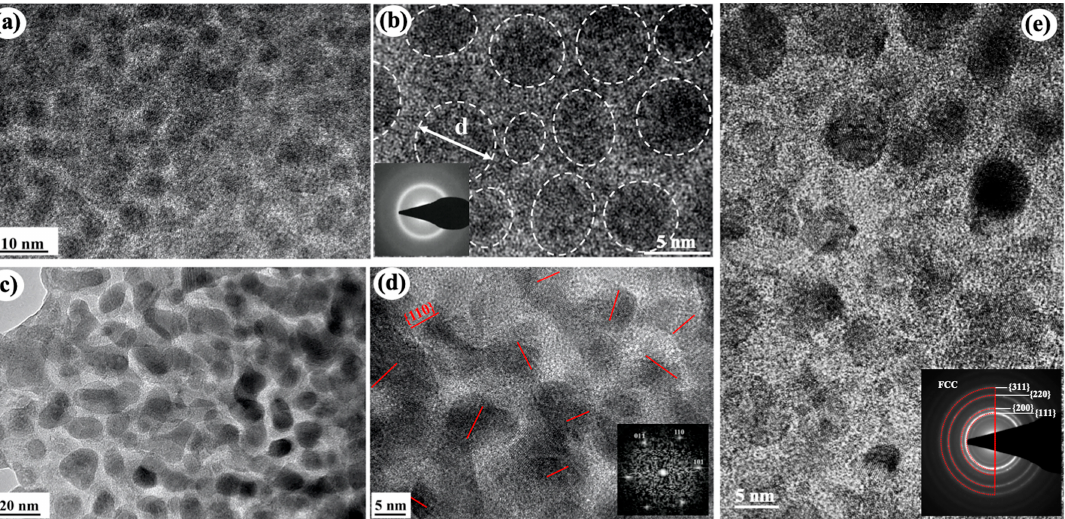
Figure 7. ( a , b ) Cross-sectional HRTEM images of the as-deposited Fe(34 at.%)-SiOC dual amorphous composite. The dashed circles indicate Fe-rich amorphous nanoclusters with the diameter of d [63]. ( c , d ) Cross-sectional HRTEM images of the 800 °C annealed Fe(34 at.%)-SiOC dual-phase nanocomposite with Fe nanocrystals in amorphous SiOC matrix. The red short lines indicate Fe nanocrystals. ( e ) Cross-sectional HRTEM image of the as-deposited Cu(22 at.%)-SiOC dual-phase composite with Cu nanocrystals in amorphous SiOC matrix [111].